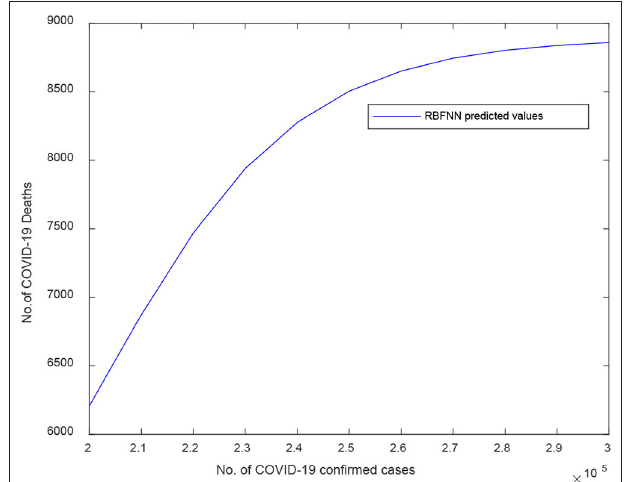
FIGURE 11 | Predicted curve for D2 using RBFNN.